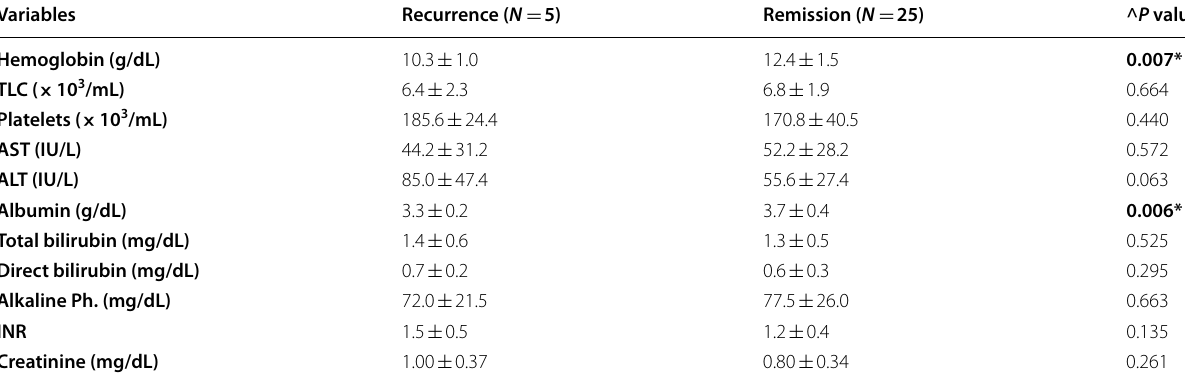
Table 7 Comparison according to tumor recurrence among HCC group regarding baseline laboratory results